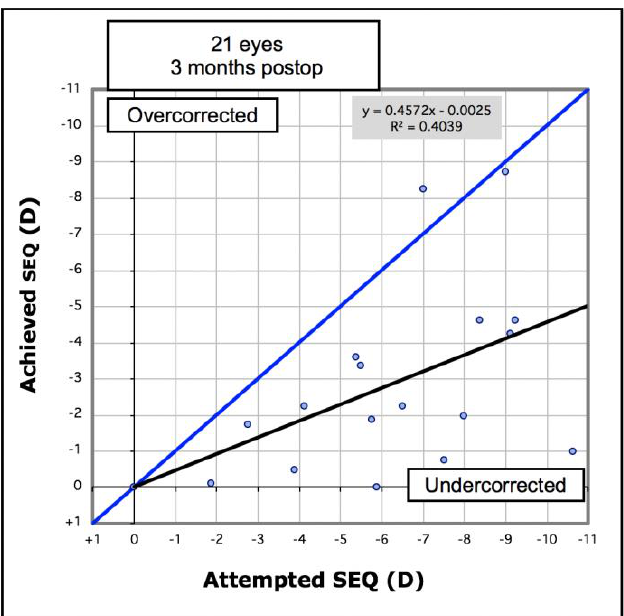
Figure 6. Attempted versus achieved spherical equivalent (SEQ) in 21 keratoconic eyes implanted with Ferrara intrastromal corneal ring segments. Black line = regression equation.